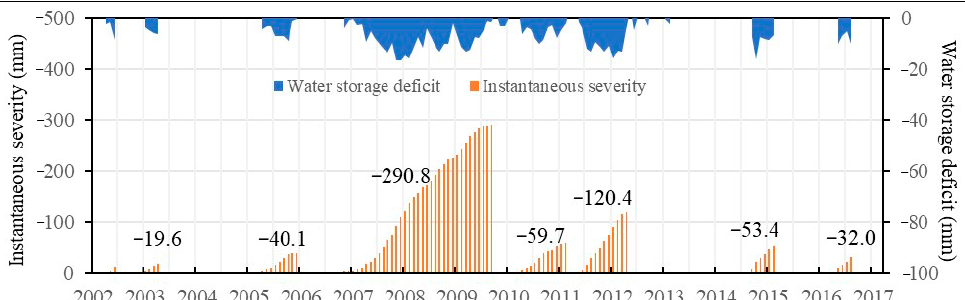
Figure 10. Instantaneous severity and associated total drought severity values and water storage deficit determined for GRACE − observed data.